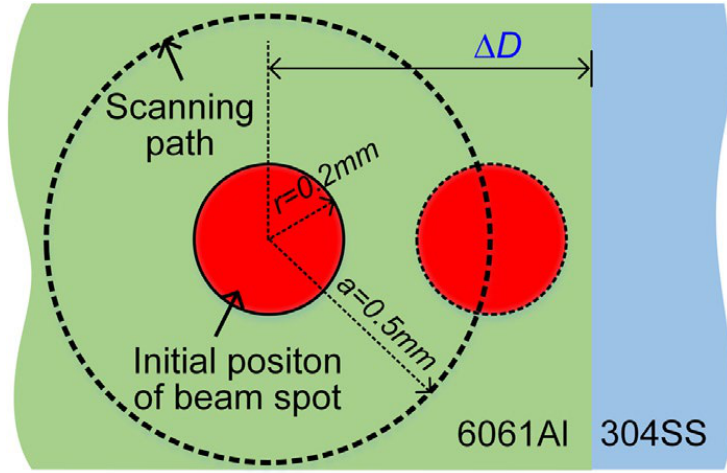
Figure 11. Diagram of offset and trajectory of the laser beam [33].